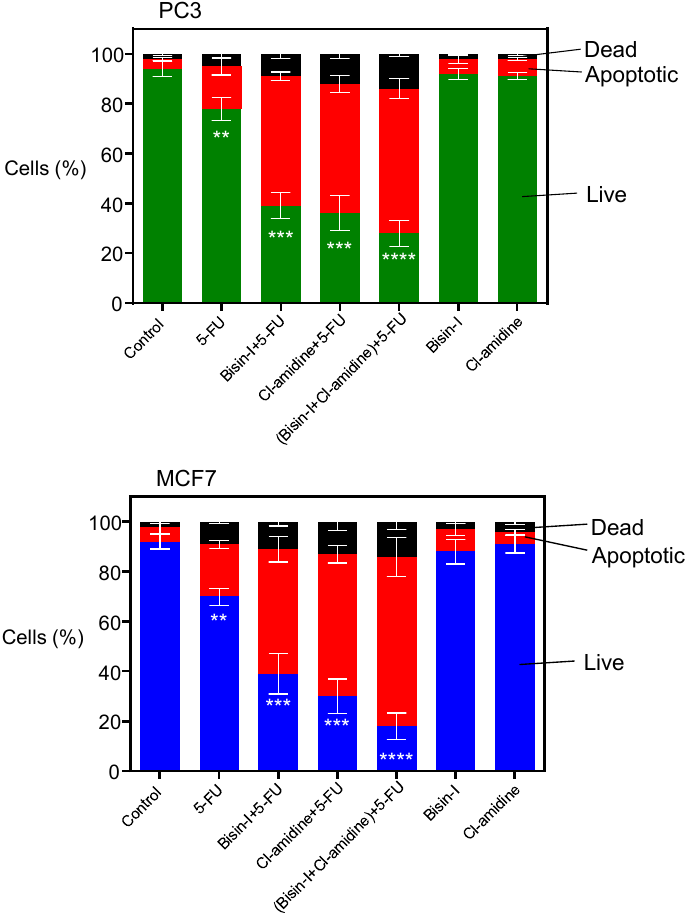
Figure 4. Cl-amidine and bisindolylmaleimide-1-mediated inhibition of EMV release increases the apoptosis of PC3 and MCF-7 cells treated with 5-FU. The Guava Viacount Cell Death Assay shows that PC3 and MCF-7 cells that were given 5-FU together with Cl-amidine, bisindolylmaleimide-I, or with a combination of Cl-amidine and bisindolylmaleimide-I, had significantly reduced levels of cell viability within 24 h compared to PC3 and MCF-7 cells receiving no EMV inhibitors and given only 5-FU. Bisindolylmaleimide-I and Cl-amidine had no significant effect on cell viability on their own. Data presented are the mean ± SEM of three independent experiments performed in triplicate (** p ≤ 0.01; *** p ≤ 0.001; **** p ≤ 0.0001 were considered statistically significant compared to the drug-treated control in the absence of